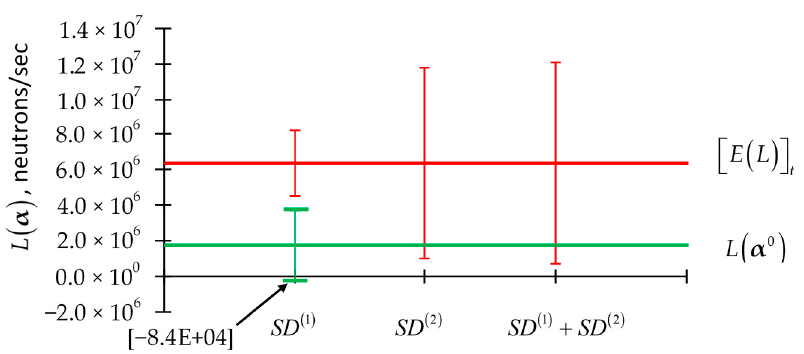
Figure 17. Comparison of (cid:16) (cid:17) ± SD ( 1 ) (in green), [ E ( L )] ± SD ( 1 ) , SD ( 2 ) , SD ( 1 ) + SD ( 2 ) (in red), due to 10% standard deviations of the uncorrelated total microscopic cross sections.